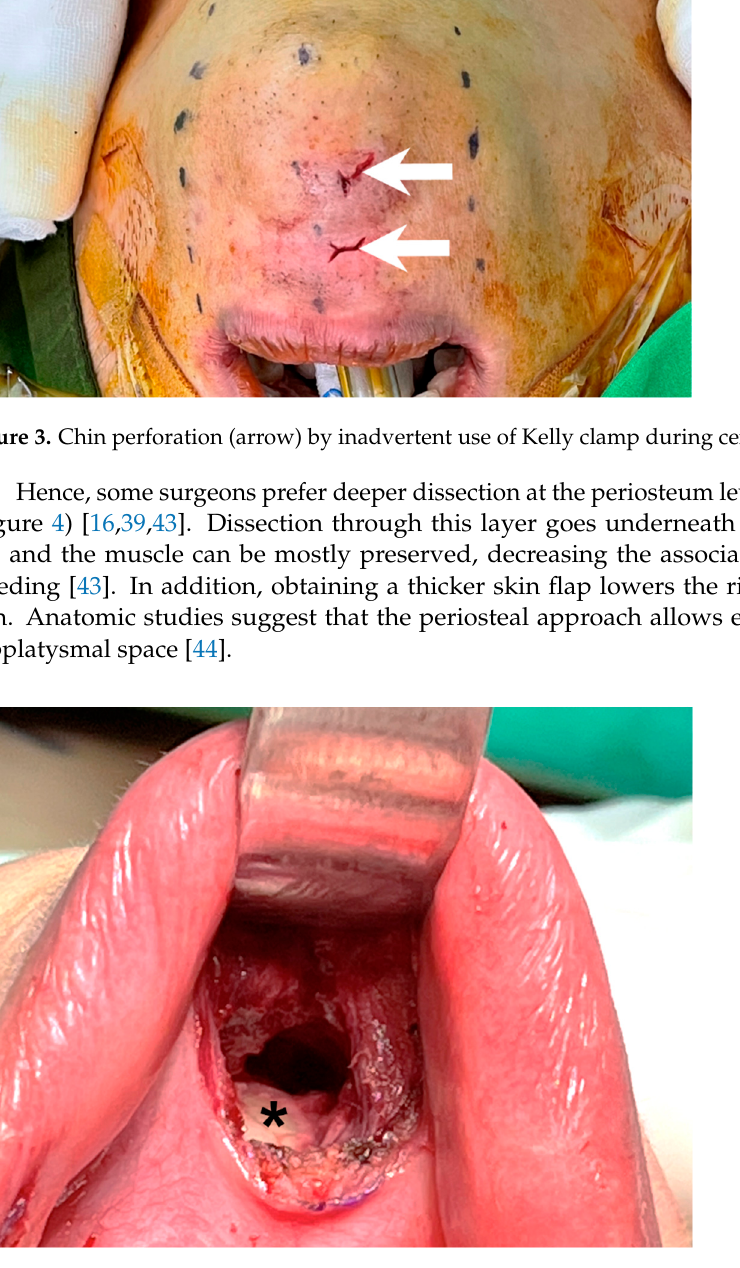
Figure 4. Dissection is performed deeper at the periosteal level (asterisk) of the mandible.